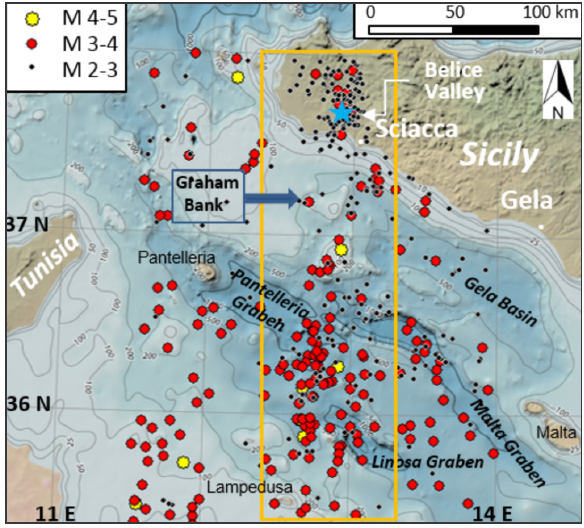
Figure 3. The distribution of earthquakes epicentres recorded be- tween 1985 to 2015 in the centralwestern side of the Sicily Channel and inland, along the Belice Valley (data from ISIDE: Italian seis- mological instrumental and parametric database, http://iside. rm.ingv.it). The blue star shows the location of the strong seismic sequence of the Belice earthquake. The orange box images a NS belt were the seismicity is highly concentrated. (Bathymetry from Gebco - General bathymetric chart of the